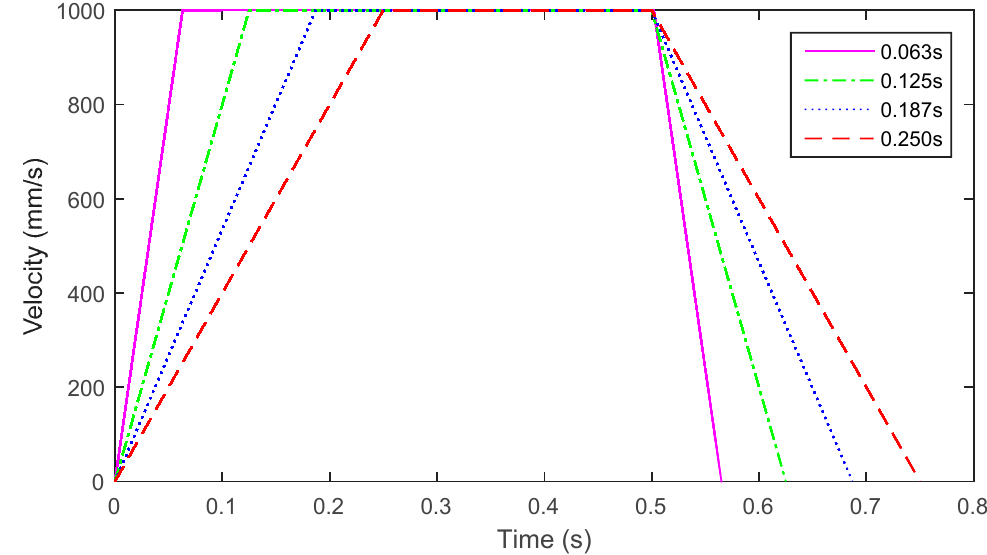
Figure 9. The experiment in which the robot moved with a constant configuration: ( a ) initial position; ( b ) final position.